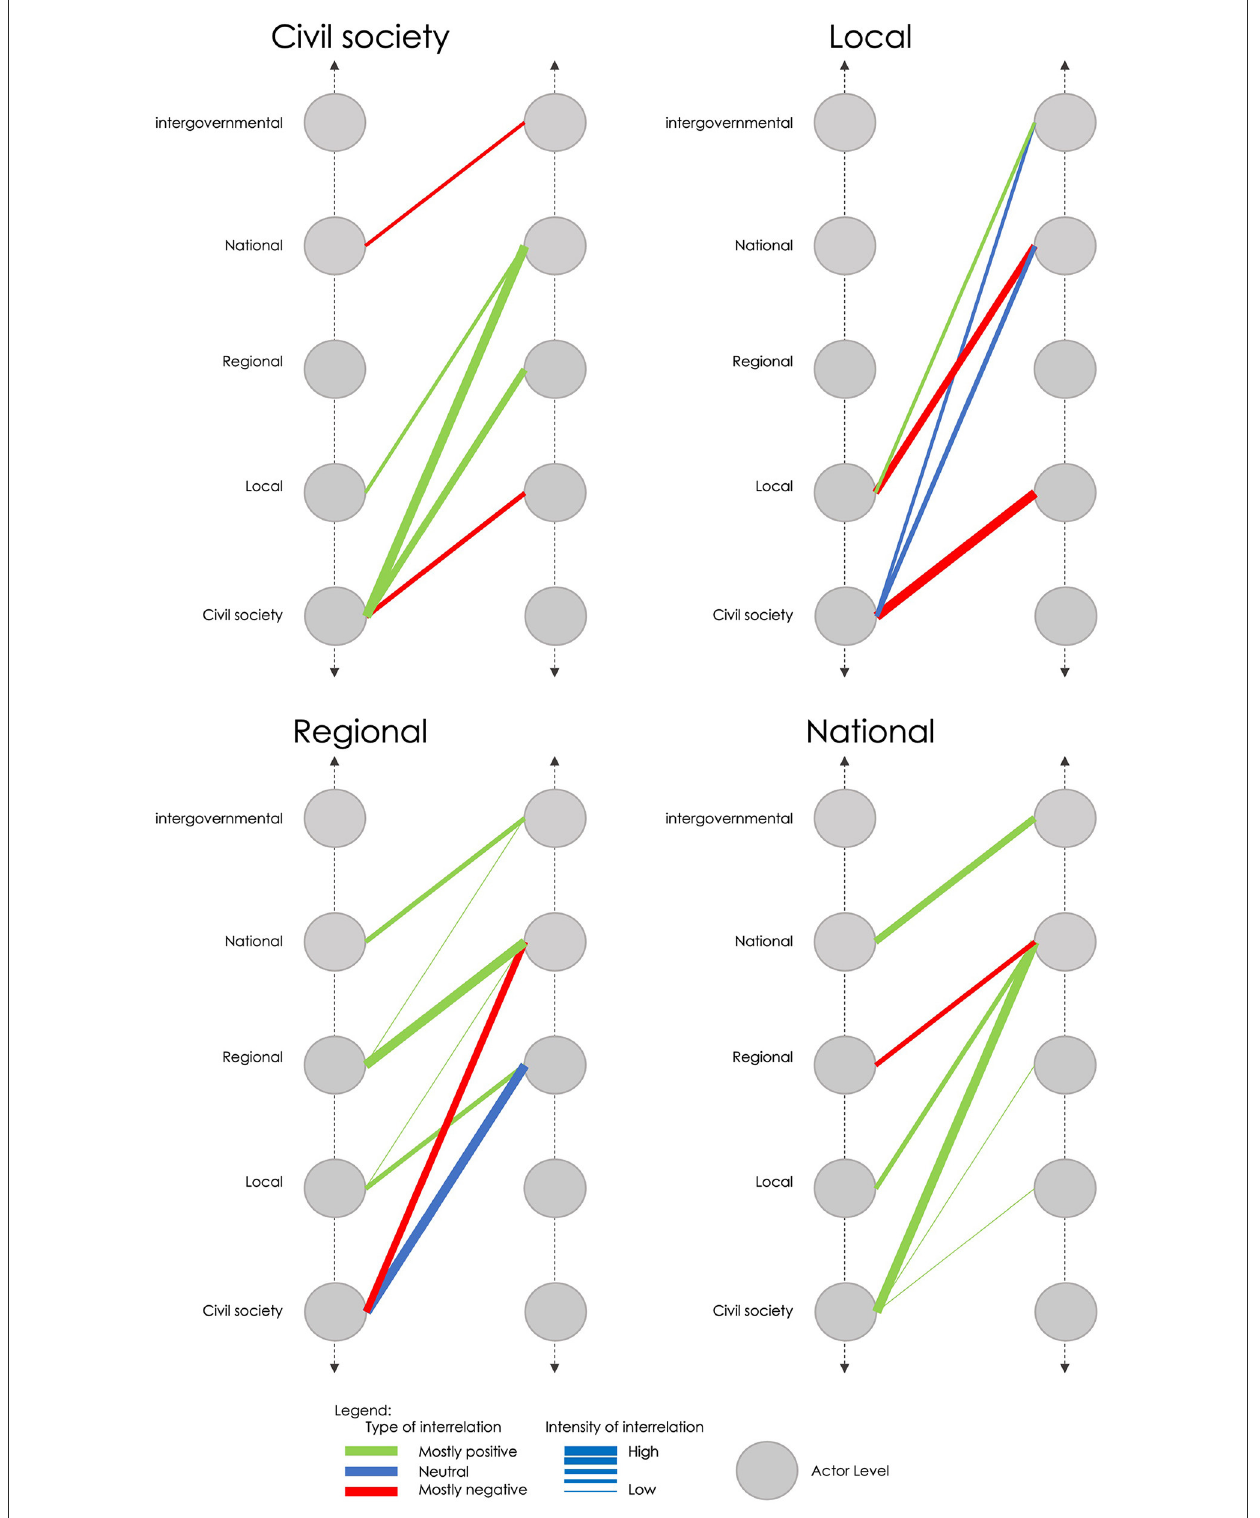
FIGURE5 Scheme of interrelation between territorial levels by type of stakeholder. Source: Prepared by the authors.